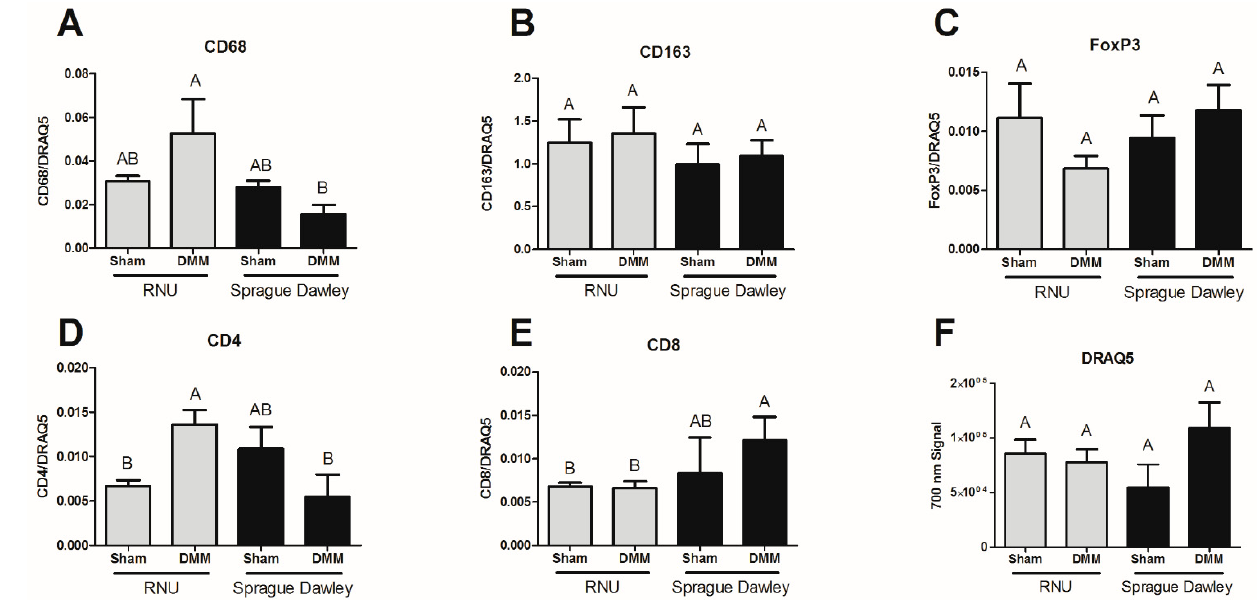
Figure 5. CD68+ staining is increased in RNU DMM-treated sites compared to Sprague Dawley. CD68 staining was quantified and showed increased levels in RNU rats ( A ). Yet, CD163 ( B ) and FoxP3 ( C ) were unaltered. CD4 staining was increased in RNU rats ( D ) while CD8 staining was lower ( E ). In addition, CD4, CD8, and FoxP3 levels were low. DRAQ5 showed no change in DNA staining ( F ). Data shown are means ± SEM of 8 animals. Letters not shared indicated a significant difference ( p < 0.05, Tukey).